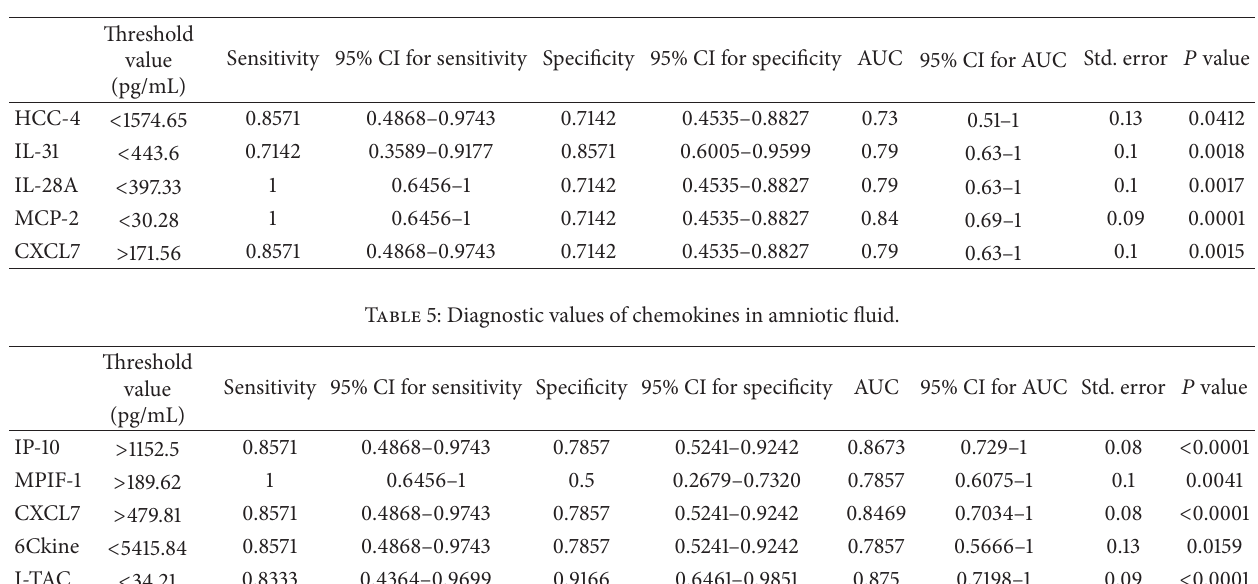
Table 4: Diagnostic values of chemokines in plasma.